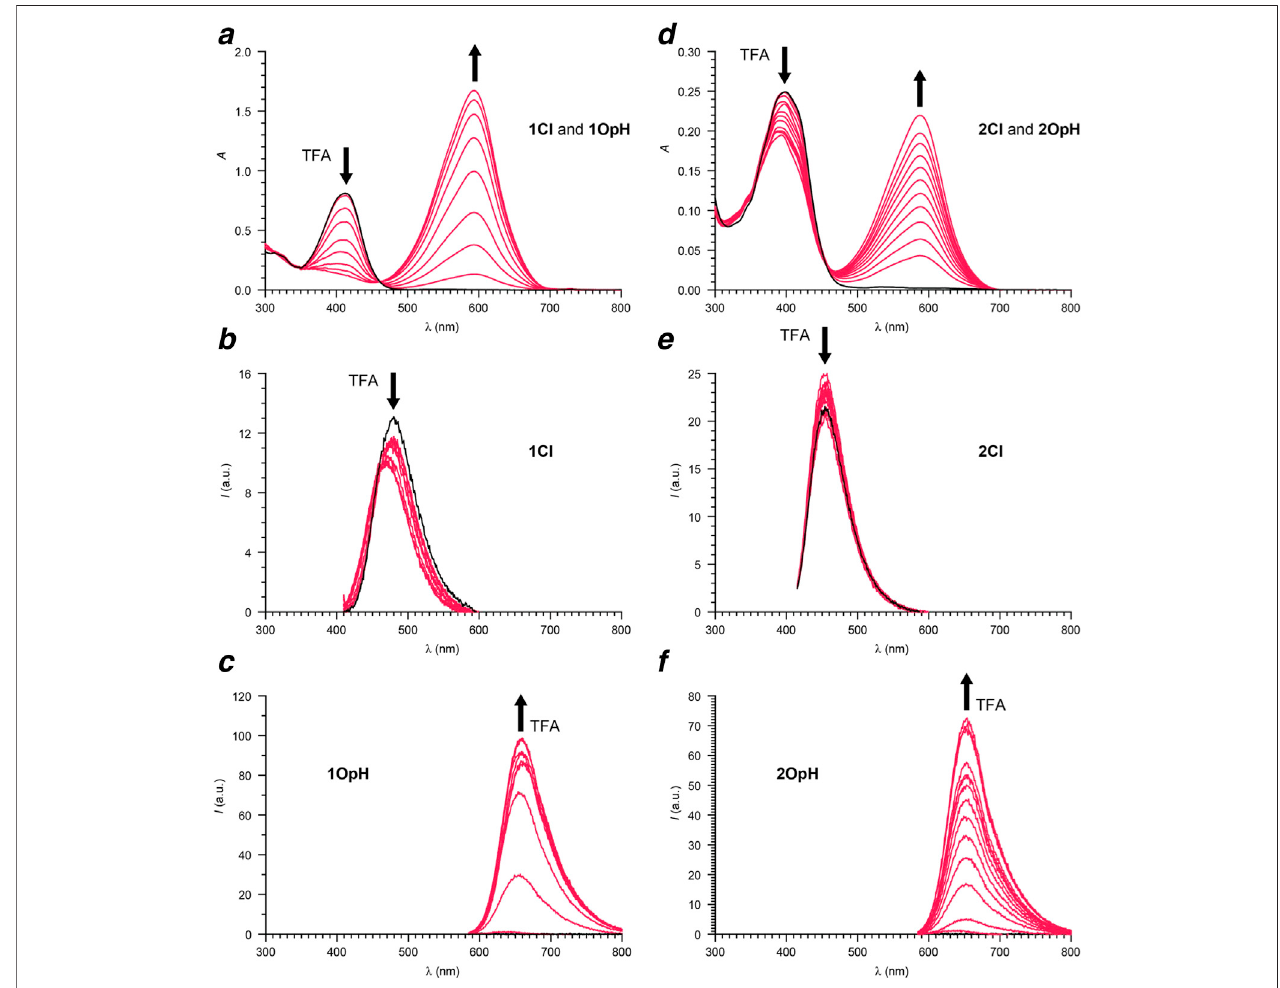
FIGURE 2 | Absorption ( a ) and emission ( b , λ Ex (cid:1) 405 nm; c , λ Ex (cid:1) 575 nm) spectra of a MeCN solution of 1 (22 µM) recorded before (black) and after (red) the addition of increasing amounts of TFA (0.1 – 1.8 eq.). Absorption ( d ) and emission ( e , λ Ex (cid:1) 405 nm; f , λ Ex (cid:1) 575 nm) spectra of a MeCN solution of 2 (7 µM) recorded before (black) and after (red) the addition of increasing amounts of TFA (0.1 – 1.8